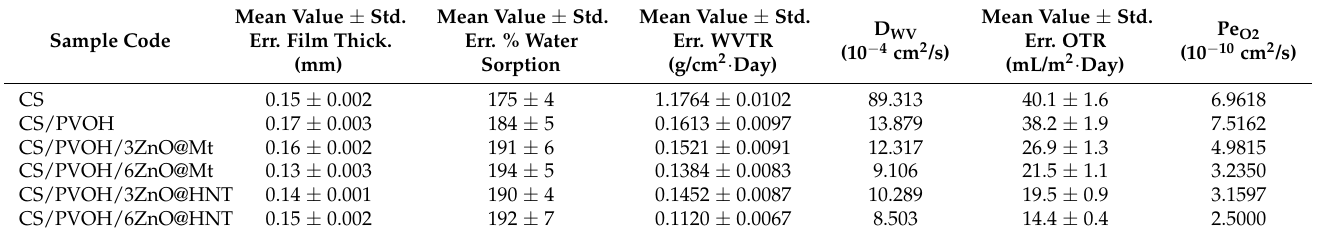
Table 3. Experimentally measured water vapor transmission rate (WVTR) and oxygen transmission rate (OTR) values and calculated water vapor diffusion coefficient (D WV ) and oxygen permeability coefficient (Pe O2 ) values.